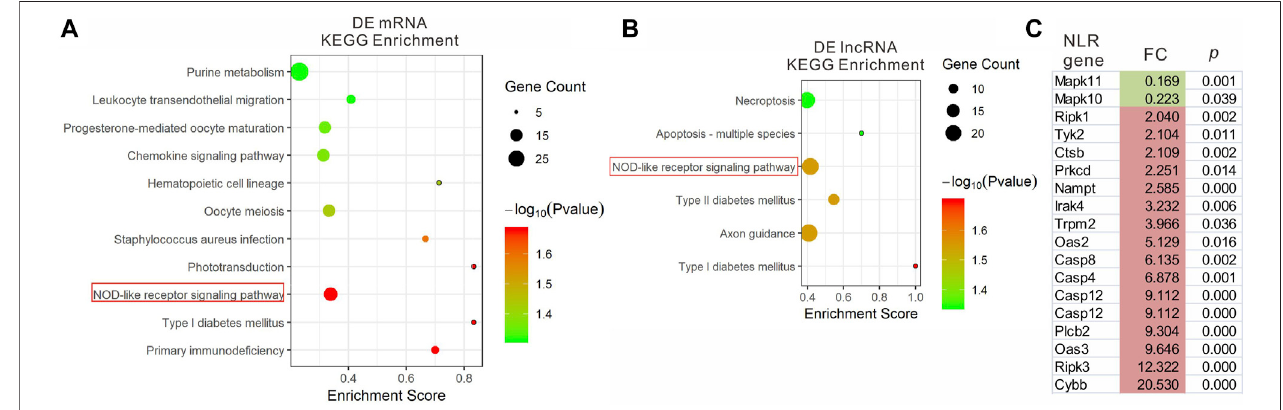
FIGURE 4 | KEGG pathway enrichment analysis of DEmRNAs (A) and DElncRNAs (B) with top enrichment scores. (C) The fold change and p . adjust of the 18 DEGs in NRL signaling